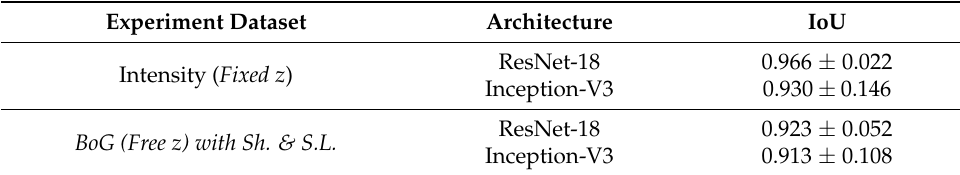
Table 3. Comparison of two backbone network architectures for our CNN predictor, in terms of reconstruction accuracy. The table reports the mean and standard deviation values achieved by both predictors on two different datasets. The abbreviations Sh. and S.L. denote the addition of shadows (Sh.) and a spotlight (S.L.) source,